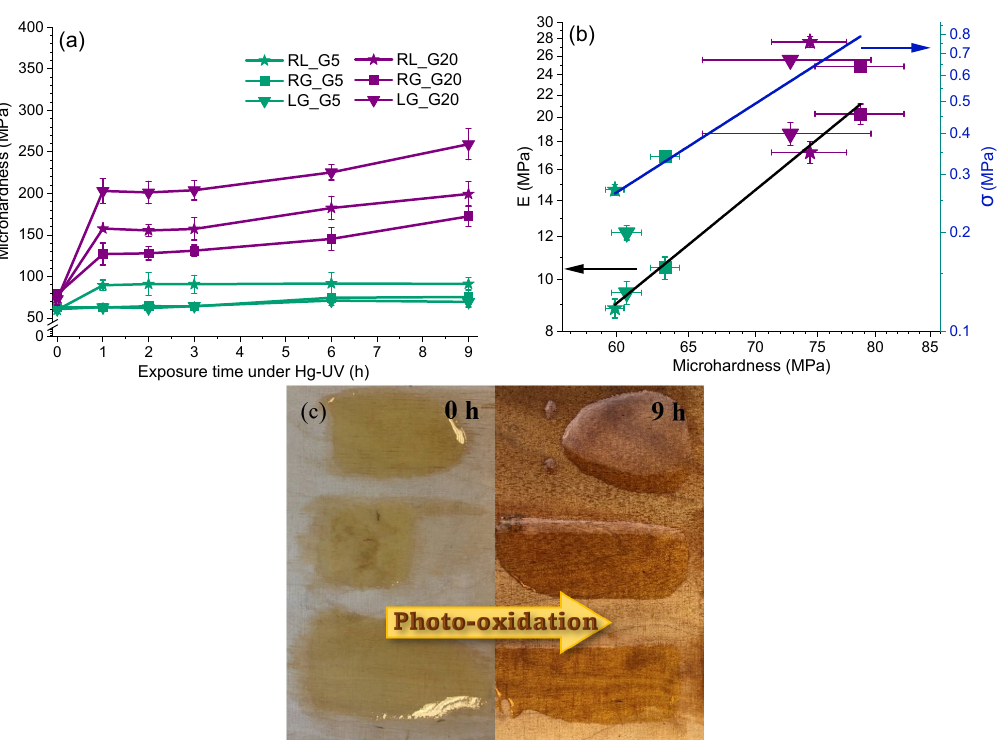
Figure 7. ( a ) Change of microhardness of coatings with GPT during Hg-UV exposure; ( b ) linear relationship between microhardness (0 h) and Young’s modulus or tensile strength for coatings with GPT (log-log scale); ( c ) plywood and coatings after 9 h of photo-oxidation.